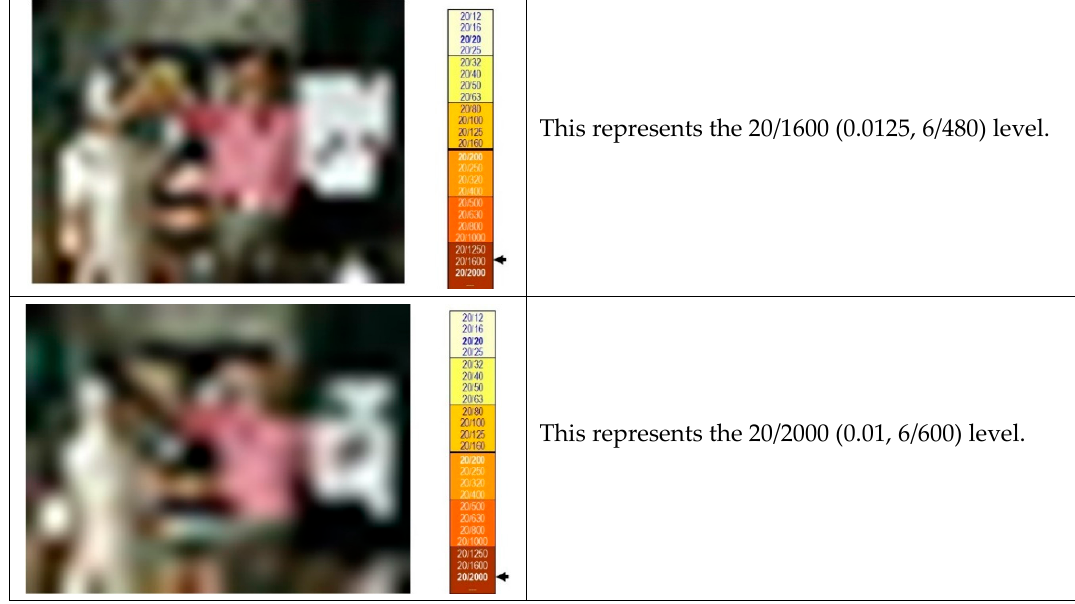
Figure B1. Visual acuity values at different levels. Figure A4. Visual acuity values at different